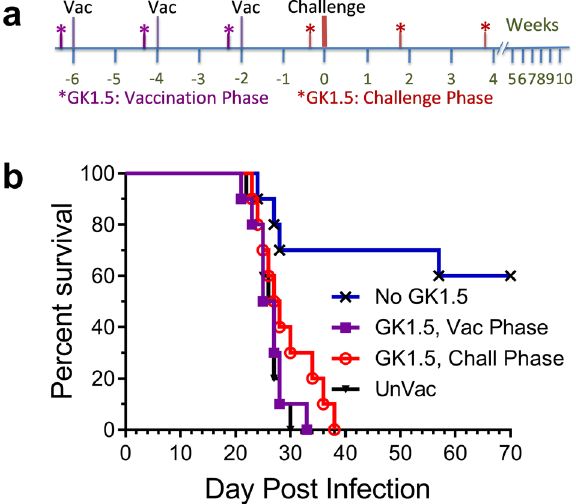
Fig. 3 Effect of CD4 + T cell depletion during the vaccination and challenge phases on GP-Cda2 protection. a Experimental outline. BALB/c mice received a prime and two biweekly boosts of the GP- Cda2 vaccine (Vac) followed by a pulmonary challenge with C. neoformans . The CD4-depleting mAb GK1.5 was administered at three biweekly intervals either during the vaccination phase (Vac Phase) 2d before each vaccine dose or the challenge phase (Chall Phase) with the fi rst dose given 2d before C. neoformans challenge. Controls included vaccinated mice that did not get GK1.5 (No GK1.5) and unvaccinated (UnVac) mice. b Kaplan – Meier survival curve of mice followed for 70 days (10 weeks) after the challenge, with percent survival recorded daily. Data are from two independent experiments, each with 5 mice/group. Signi fi cant ( P < 0.001, Mantel – Cox log-rank test) survival compared with unvaccinated mice was seen only for mice that did not get GK1.5.